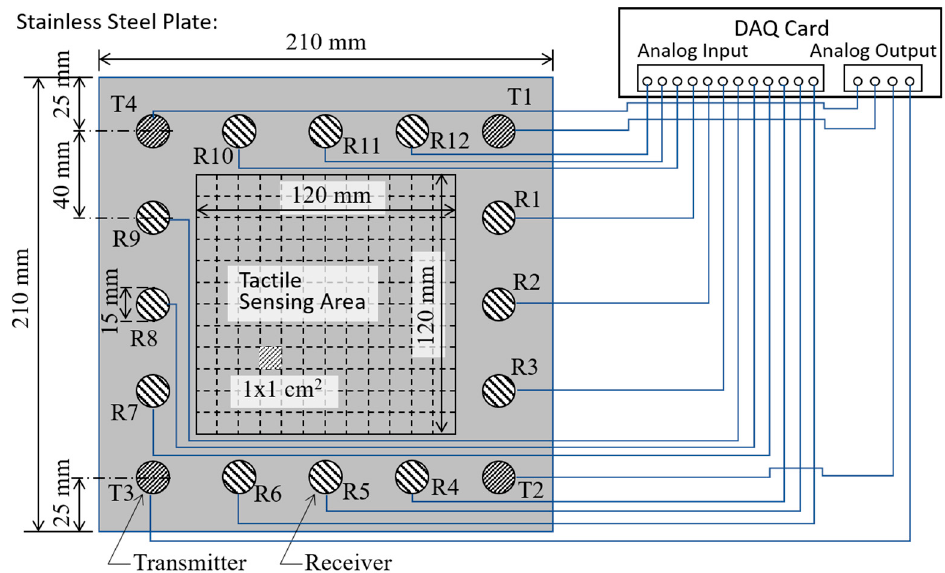
Figure 2. Schematic illustration showing dimensions of stainless-steel plate and locations of 16 disk-shaped piezo-transducers, together with associated wiring between transmitting / receiving piezo-transducers and analog output / input ports of DAQ card. Note that T1~T4 are transmitting piezo-transducers, while R1~R12 are receiving piezo-transducers.